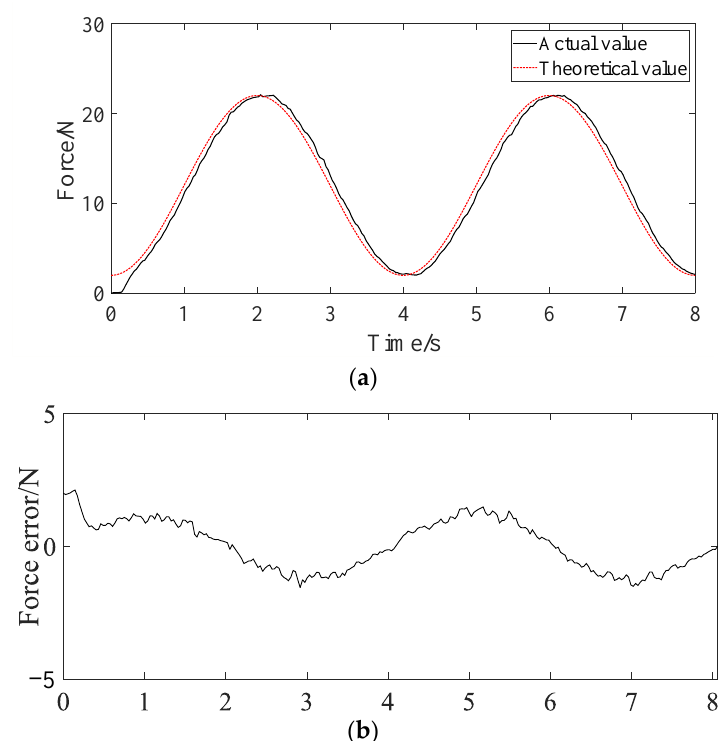
Figure 12. The sinusoidal force command following experimental results. ( a ) Sinusoidal command tracking curve. ( b ) Sinusoidal command tracking error curve.